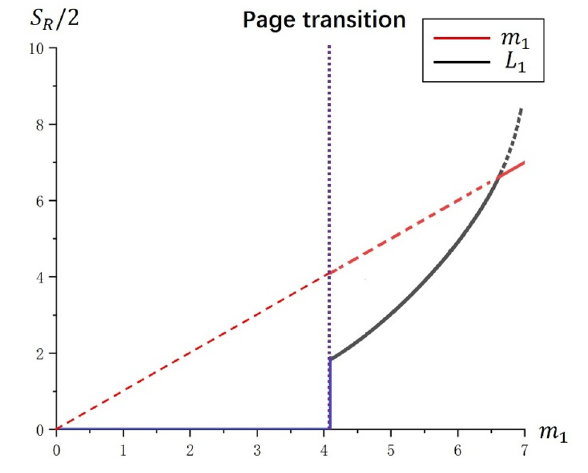
Figure 3 . We set 4 G N = 1 and plot the half of the reflected entropy as a function of the horizon length m 1 . The solid curves are half the reflected entropy between R 1 and R 2 . The purple vertical dashed line characterizes the Page transition when 2 m 1 = m 3